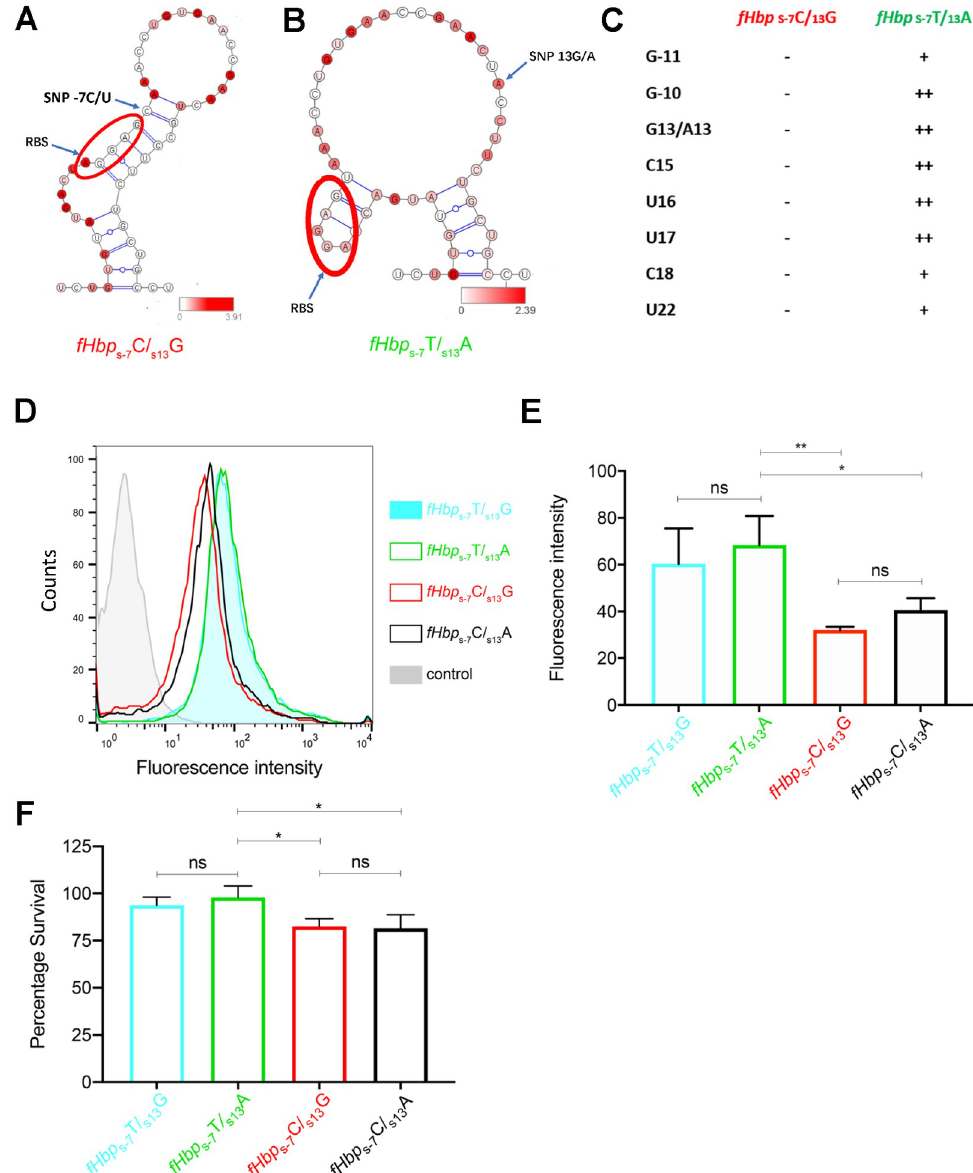
Fig 4. Secondary structure of the RNA structure at 37˚C around the RBS calculated using RNAstructure and SHAPE reactivity data. (A) fHbp s-7 C/ fHbp s13 G and (B) fHbp s-7 T/ fHbp s13 A; SHAPE reactivity data are mapped on the RNA structure and colour coded by intensity as shown on the bars; the RBS is circled in red (C) Nucleotides with reactivity are listed in the table as strong (++), medium (+) and weak (-). Representative flow cytometry histograms and geometric mean fluorescence (D, E) of surface fHbp on N . meningitidis with SNPs fHbp s-7 T/ fHbp s13 G (blue filled area), fHbp s-7 T/ fHbp s13 A (solid green line), fHbp s-7 C/ fHbp s13 G (solid red line) or fHbp s-7 C/ fHbp s13 A (solid black line). Bacteria were grown at 37˚C, and fHbp detected with anti-fHbp pAb; control (grey filled), bacteria with no primary antibody. (F) Serum sensitivity assays of N . meningitidis strains with SNPs as indicated. Error bars show SD (n = 3), � p < 0.05, �� p < 0.01 (n = 3, two-way